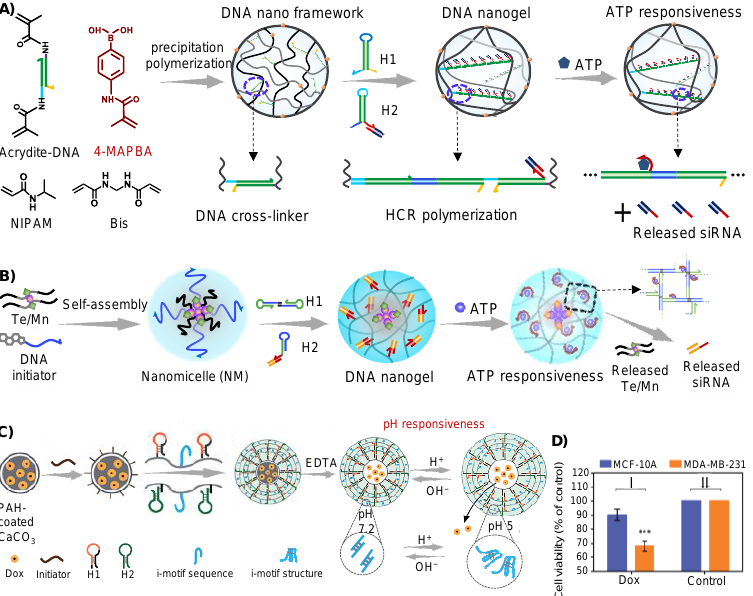
Figure 5. Hybrid DNA hydrogel prepared through HCR strategy for cancer therapy. ( A ) Schematic of the preparation and drug release of hybrid DNA nanogel. Reproduced with permission. Copyright 2021 [52], Nature Portfolio. ( B ) The principle of hybrid DNA nanogel based on C-HCR-synthesized networks. Reproduced with permission. Copyright 2021 [51], Wiley-VCH Verlag GmbH. ( C ) The schematic of pH-responsive hybrid DNA hydrogel for the DOX release. ( D ) Cytotoxicity assay of the pH-responsive hydrogel loaded with DOX into MCF-10A cells and MDA-MB-231 malignant breast cancer cells. *** p < 0.001. Reproduced with permission. Copyright 2017 [53], Royal Society